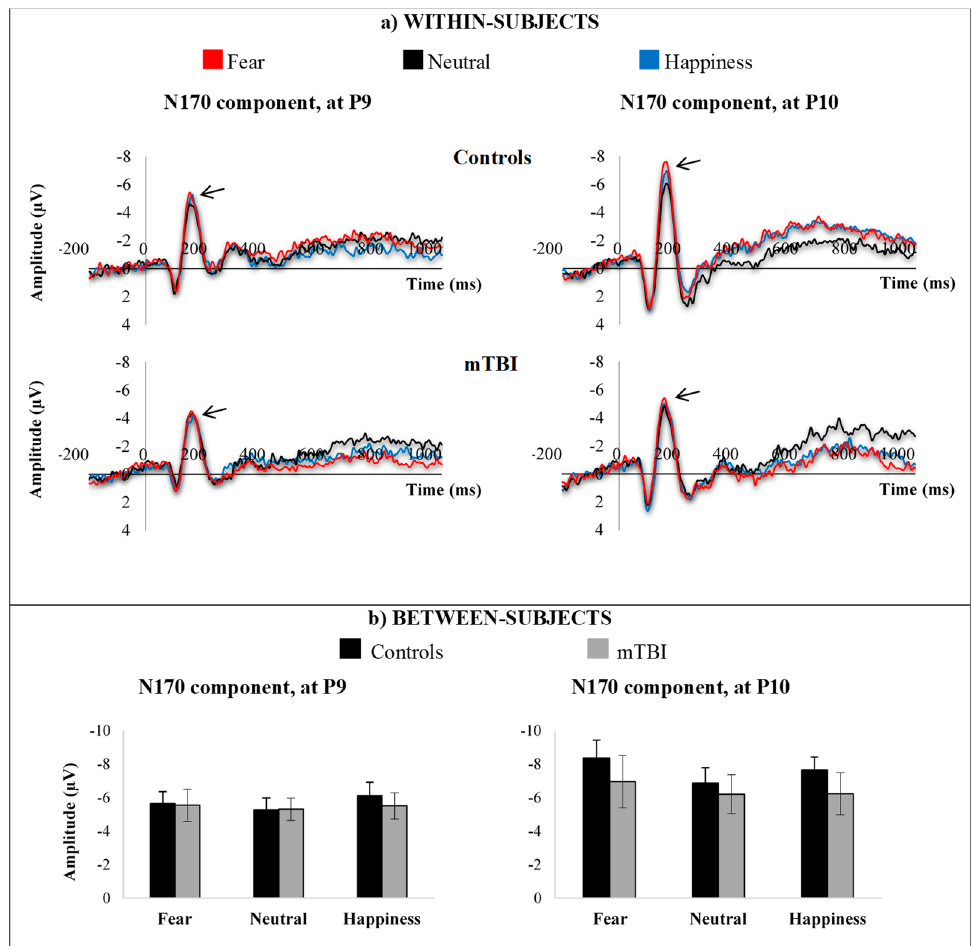
Figure 4. N170 responses at P9 electrode site (left hemisphere) and P10 electrode site (right hemisphere), ( a ) within-subjects and ( b ) between-subjects, according to emotional expressions (fear, neutrality, happiness).